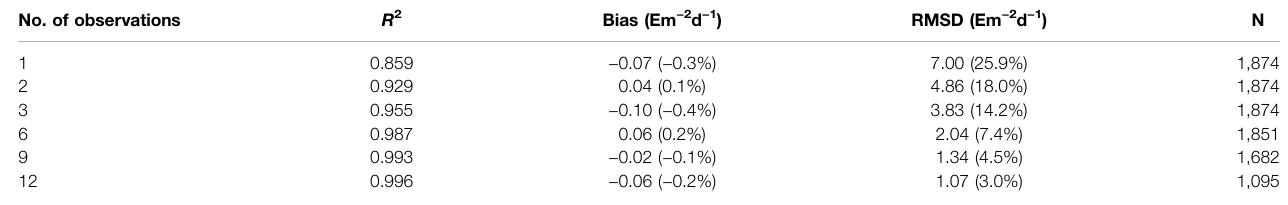
TABLE 1| Statistics ofcomparing cos ( θ s ) -weighted < E PAR > withactual (theoretical) < E PAR > using different number ofobservations at randomly distributed hourly times duringthedayonJanuary1andJuly1,2018,atoceanlocationswithin60 ° Sto40 ° Nand180 ° Wto180 ° E.Thenumberofdatapoints( N )isslightlydifferentwhensixand more hourly observations per day are used, because such number of observations may not be available for some locations during some days of the year. No. of observations R 2